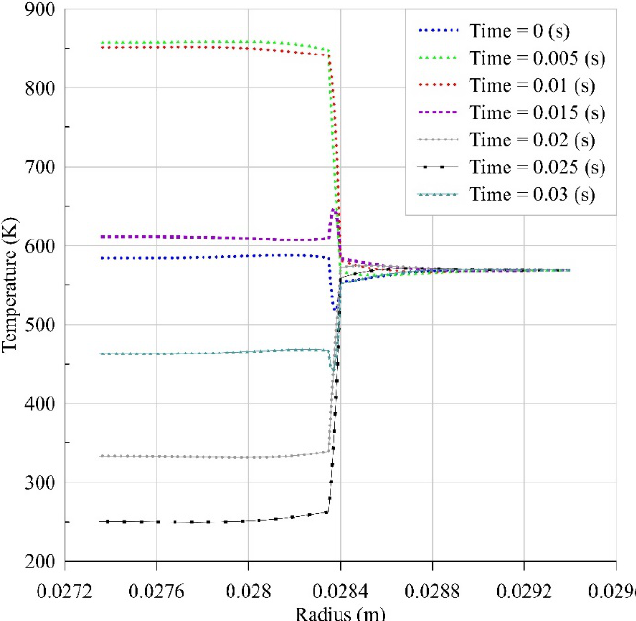
Figure 10. Flow temperature in the gap = 50 μm.